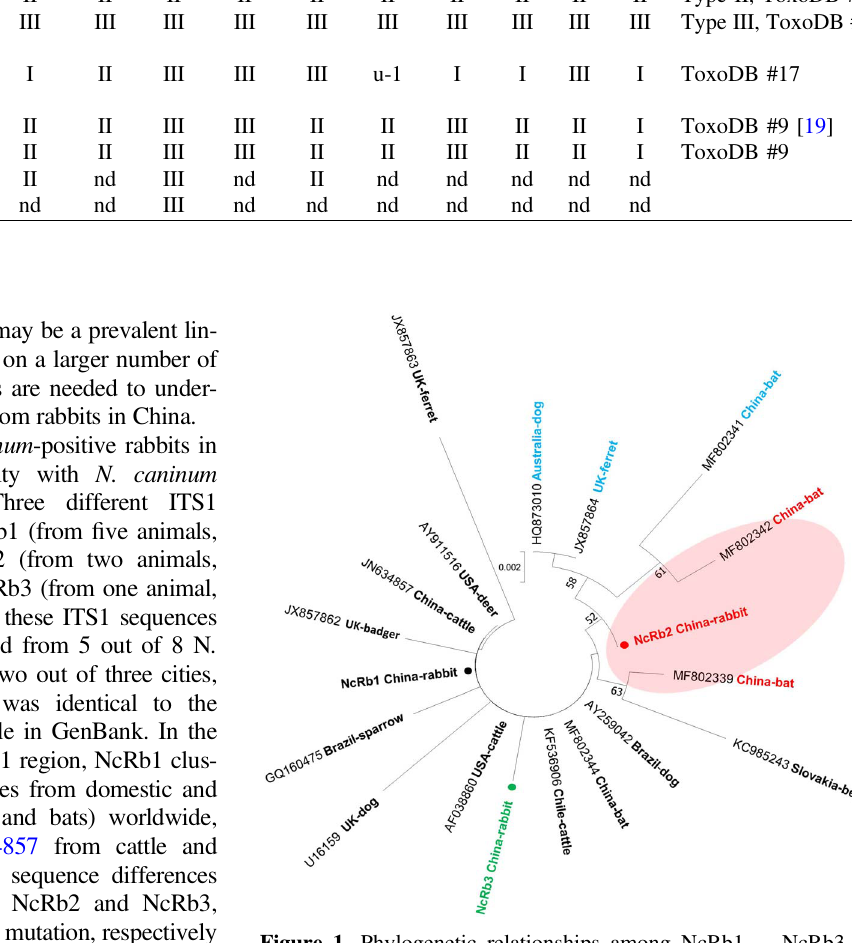
Figure 1. Phylogenetic relationships among NcRb1 (cid:1) NcRb3 in inferred by a neighbor-joining analysis of the partial ITS1 region. Bootstrap values greater than 50% from 1000 pseudoreplicates are shown. The sequences in this study are marked by closed